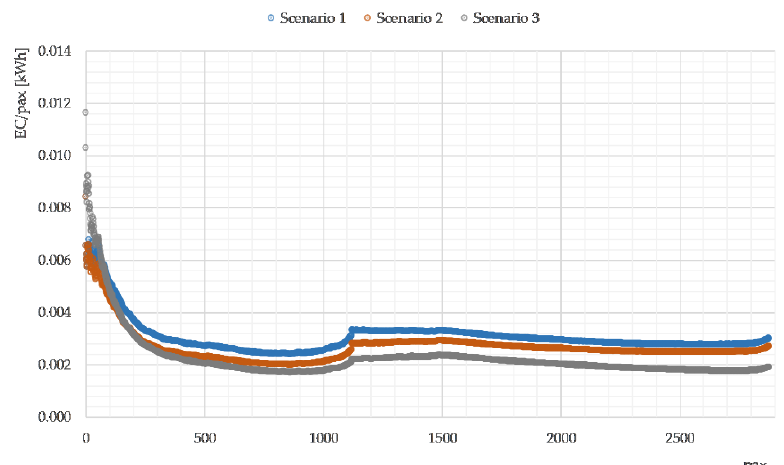
Figure 8. Energy consumption as a function of the number of passengers served.